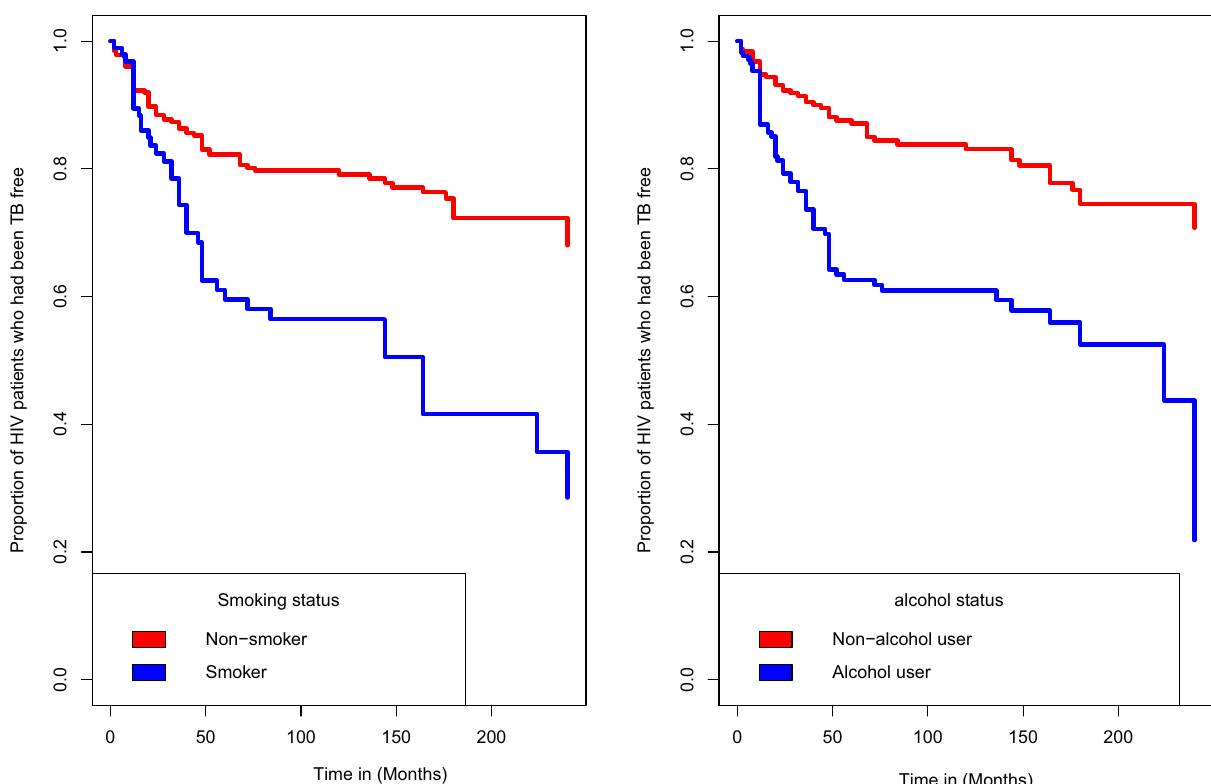
Figure 3. Kaplan-Meier survival curves for TB free co-infection free survival time of patients by smoking status and alcohol status of